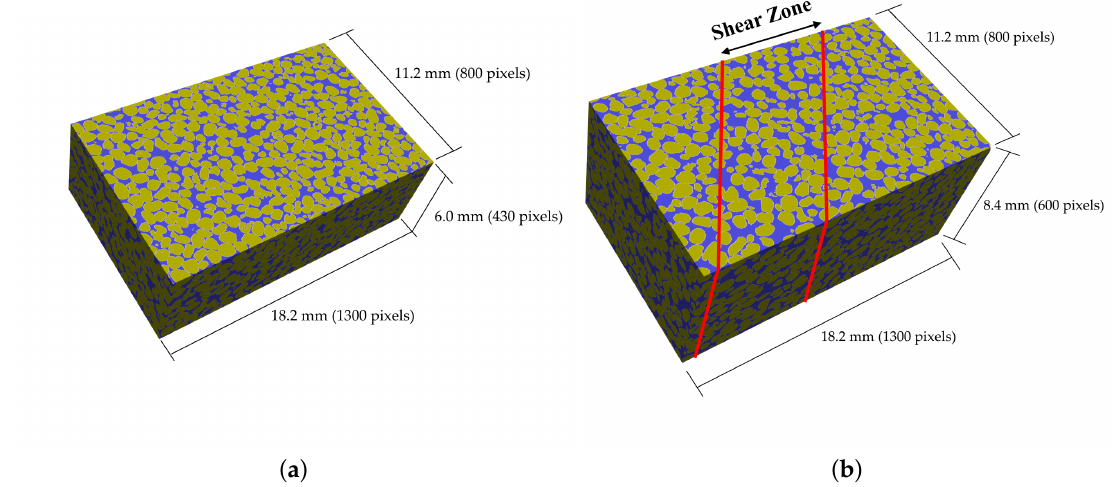
Figure 16. Reconstructed Ottawa 20–30 specimens ( a ) un-sheared and ( b ) sheared